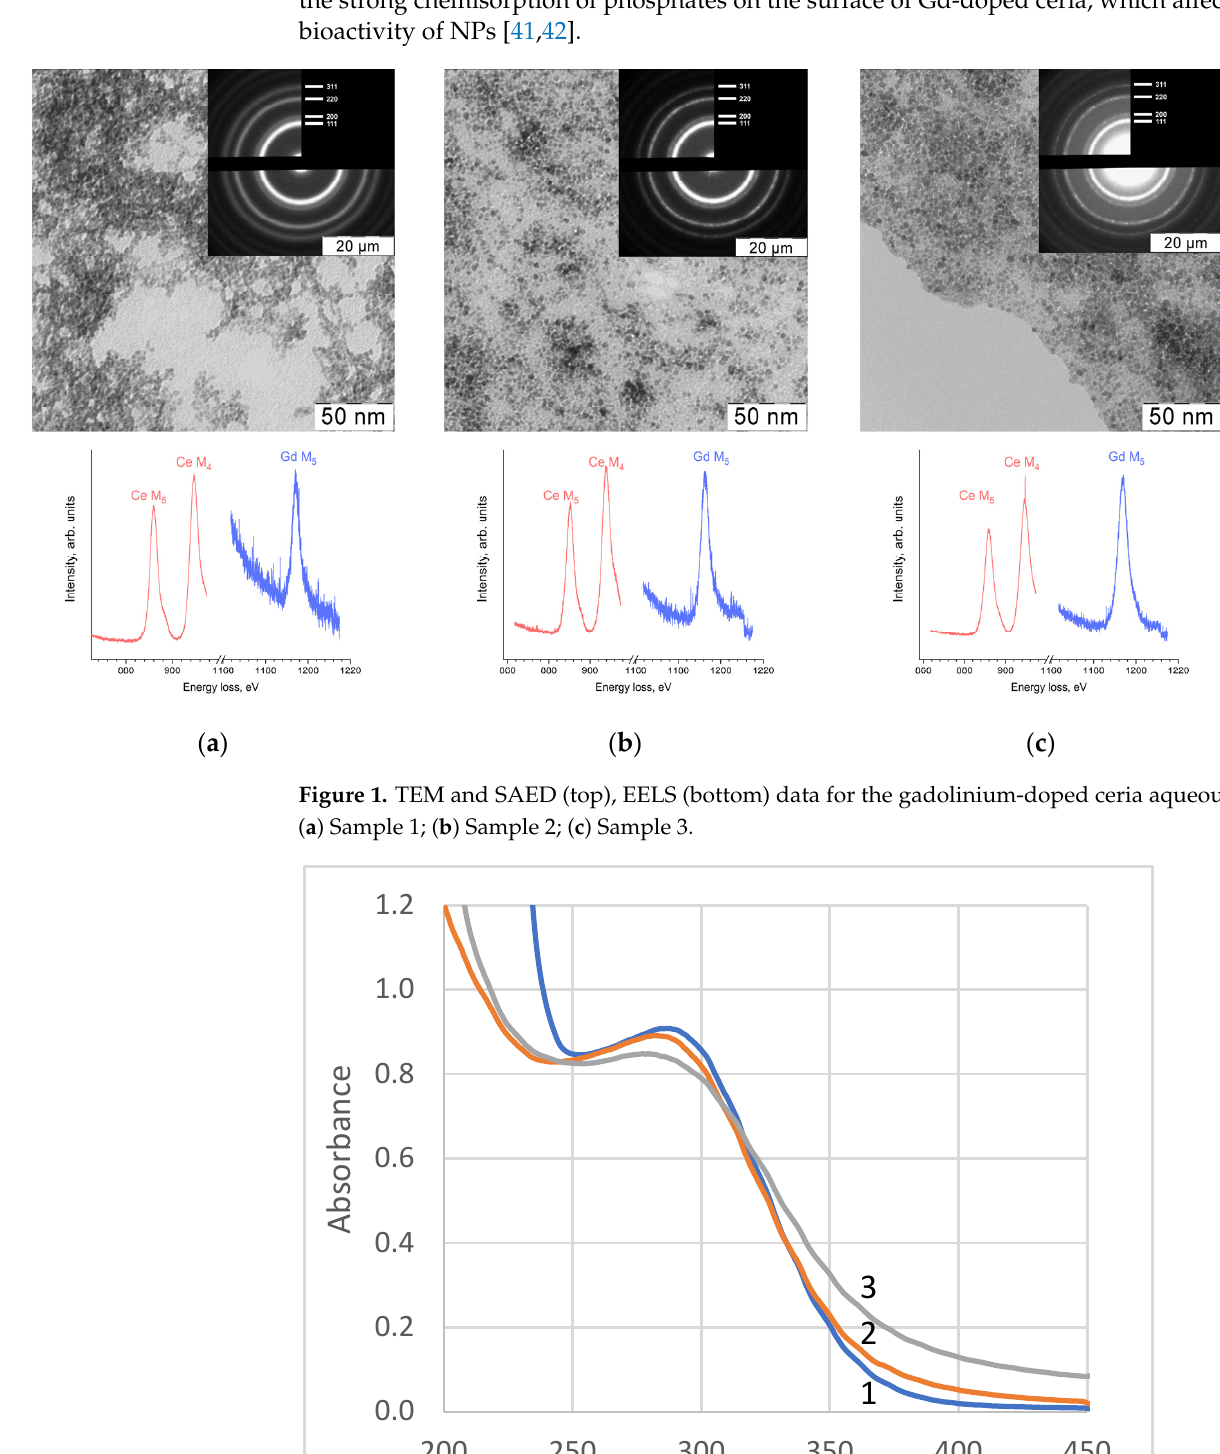
Figure 2. UV-vis spectra of gadolinium-doped ceria sols, Samples 1–3.